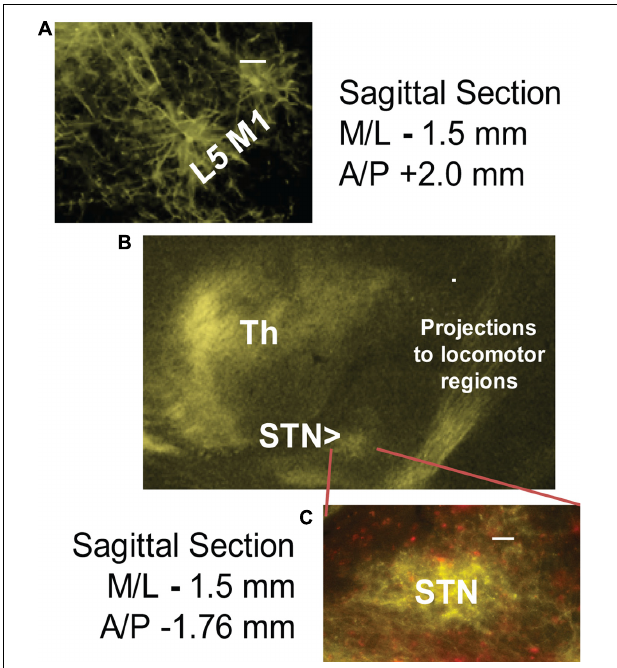
FIGURE 2 | Successful cortico-subthalamic (M1-STN) projection transfection was confirmed by the presence of EYFP (yellow) in (A) layer 5 M1 pyramidal cells, (B) M1 descending projections and collaterals, and (C) M1-STN terminals. mCherry (red) staining indicates WGA/Cre construct injection site. The middle panel (B) shows the opsin transfection pattern in the region around the STN. Scale bars = 100 µ